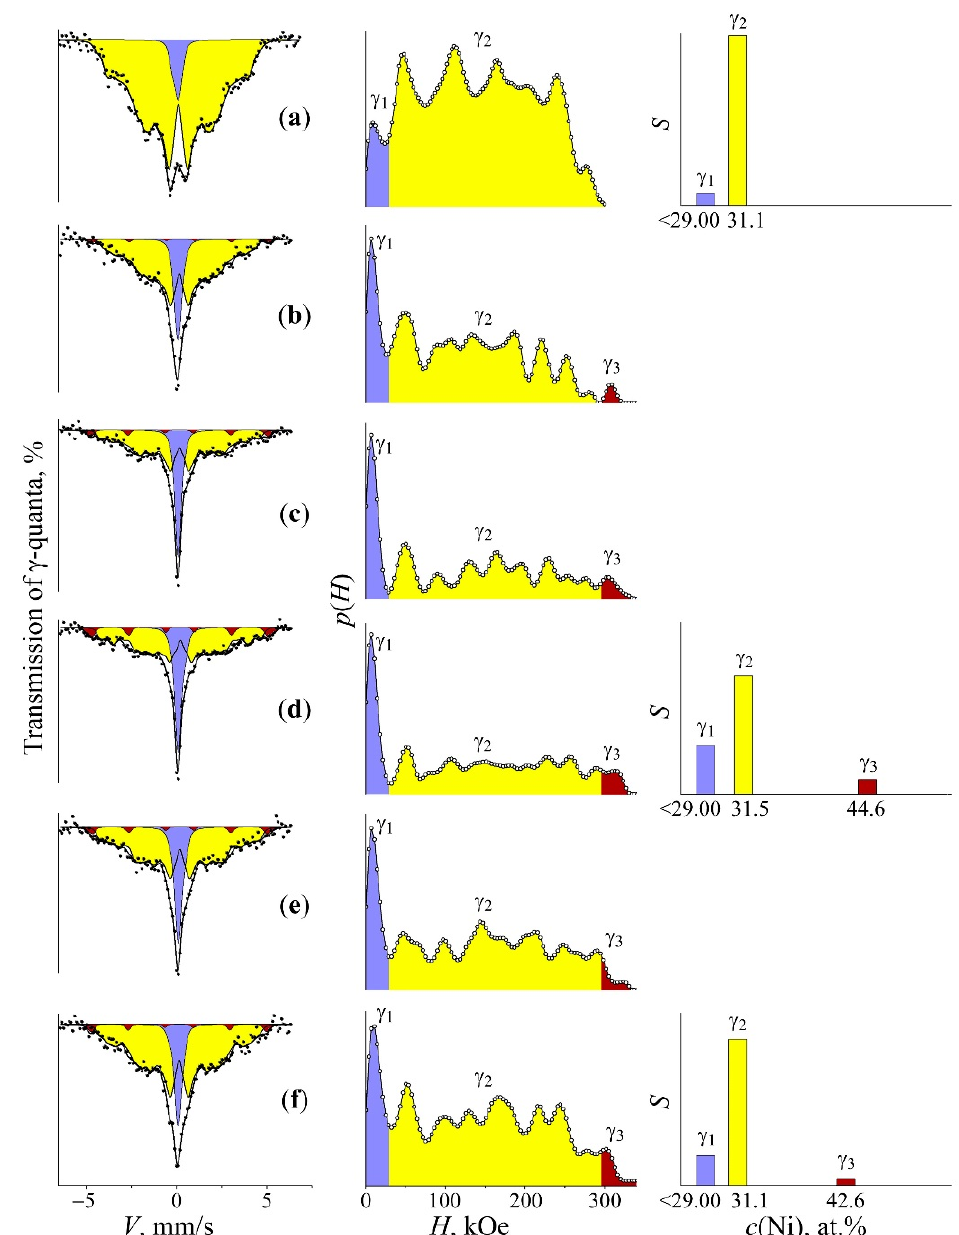
Figure 4. The Mössbauer spectra and the spectral components γ 1 , γ 2 , and γ 3 reconstituted using p ( H ) and histograms of intensities S of Mössbauer spectra components and the concentration composition c (Ni) of the FeNi 31.1 alloy. Treatment: ( a ) (i) quenching in liquid nitrogen for the formation of α -martensite and (ii) fast heating up to 600 ◦ C for 10 min upon α → γ transformation; ( b – f ) slow heating (0.2 K/min) up to 400, 430, 470, 490, and 510 ◦ C upon α → γ transformation, respectively, with subsequent fast heating up to 600 ◦ C for 10 min upon austenitization.